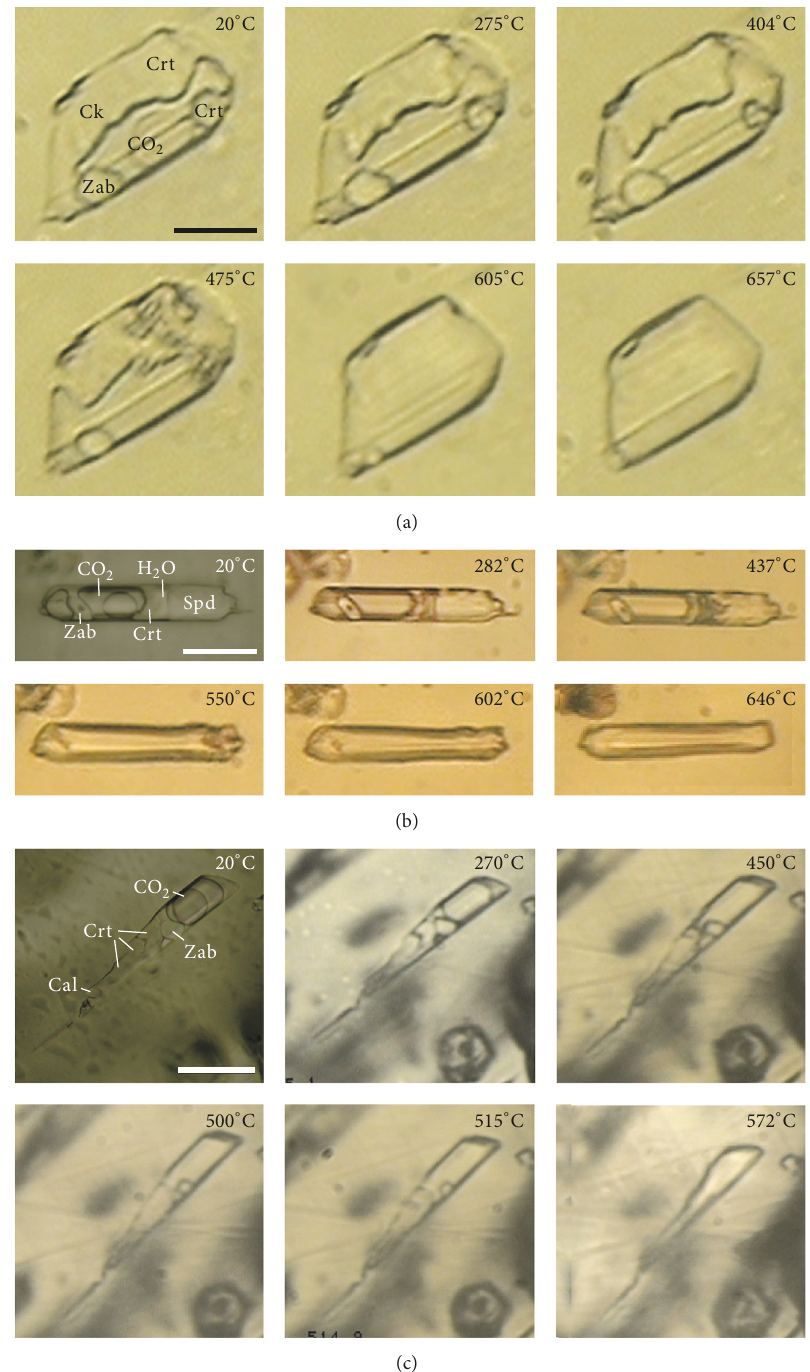
Figure 8: The homogenization processes of CIs in spodumene from the Jiajika deposit, China. Recorded images of (a), (b), and (c) are from experimental numbers 3, 12 and 30 respectively. They show the dissolution of melt into the carbonic aqueous fluid during the total homogenization process. Zab-Zabuyelite, Crt- Cristobalite, Cal- Calcite, Ck- cookeit. The length of the scale bar is 10 𝜇